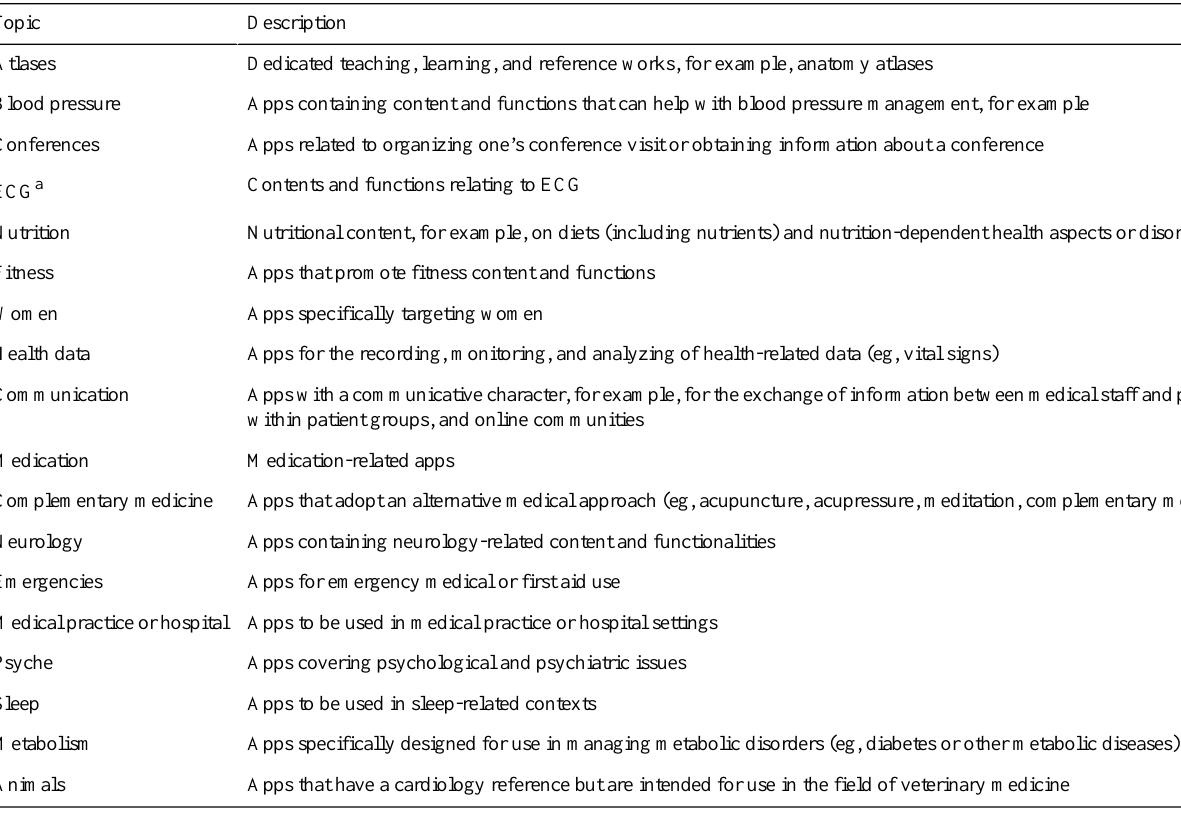
Table 3. Definition of the app-related topics, specifically for a cardiology context.